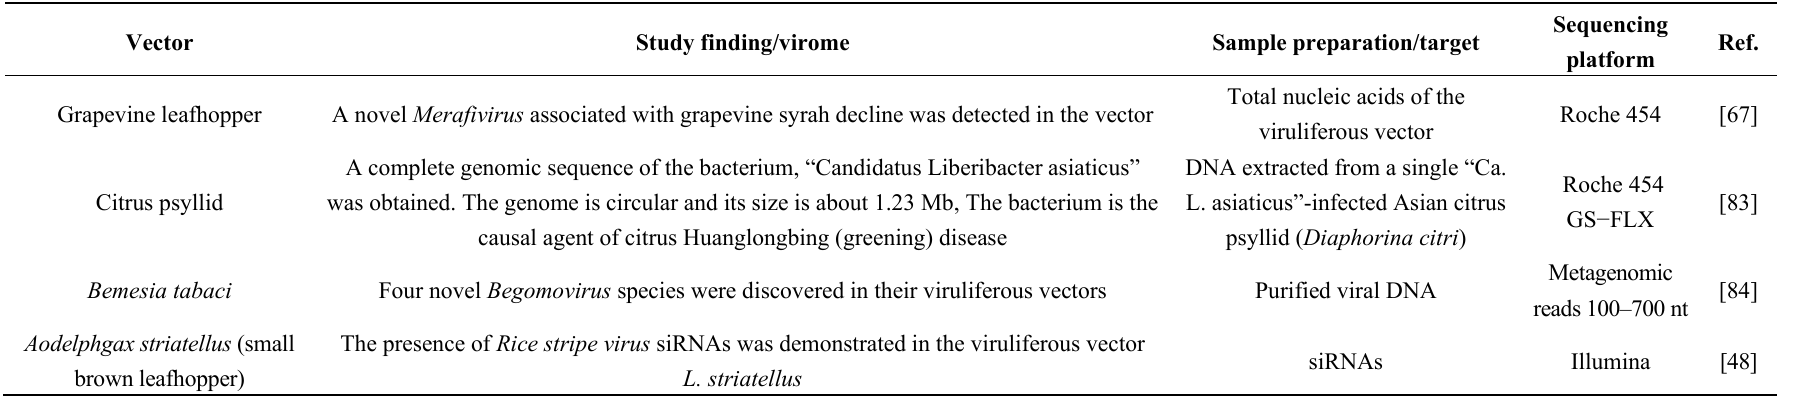
Table 7. Next-generation sequencing of RNA viruses, DNA viruses or bacteria DNA from insect